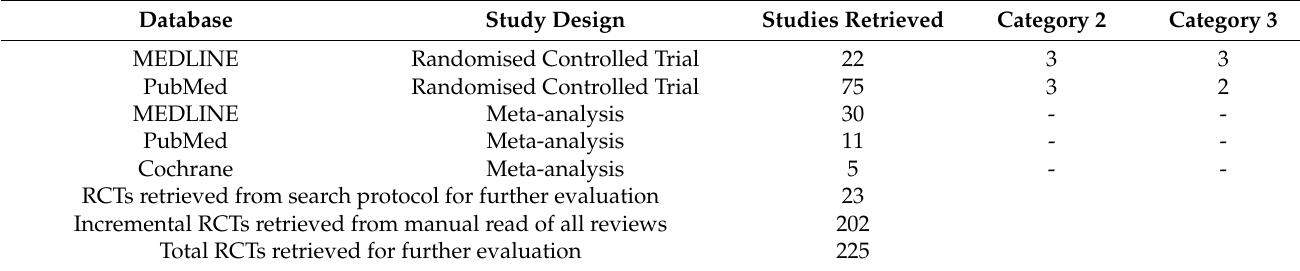
Table 2. Summary of search